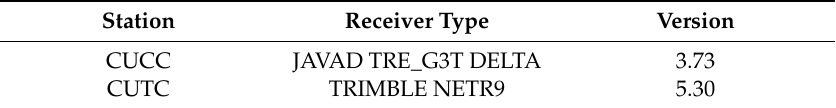
Table 2. Receiver information of CUCC and CUTC on DOY 151, 2018.